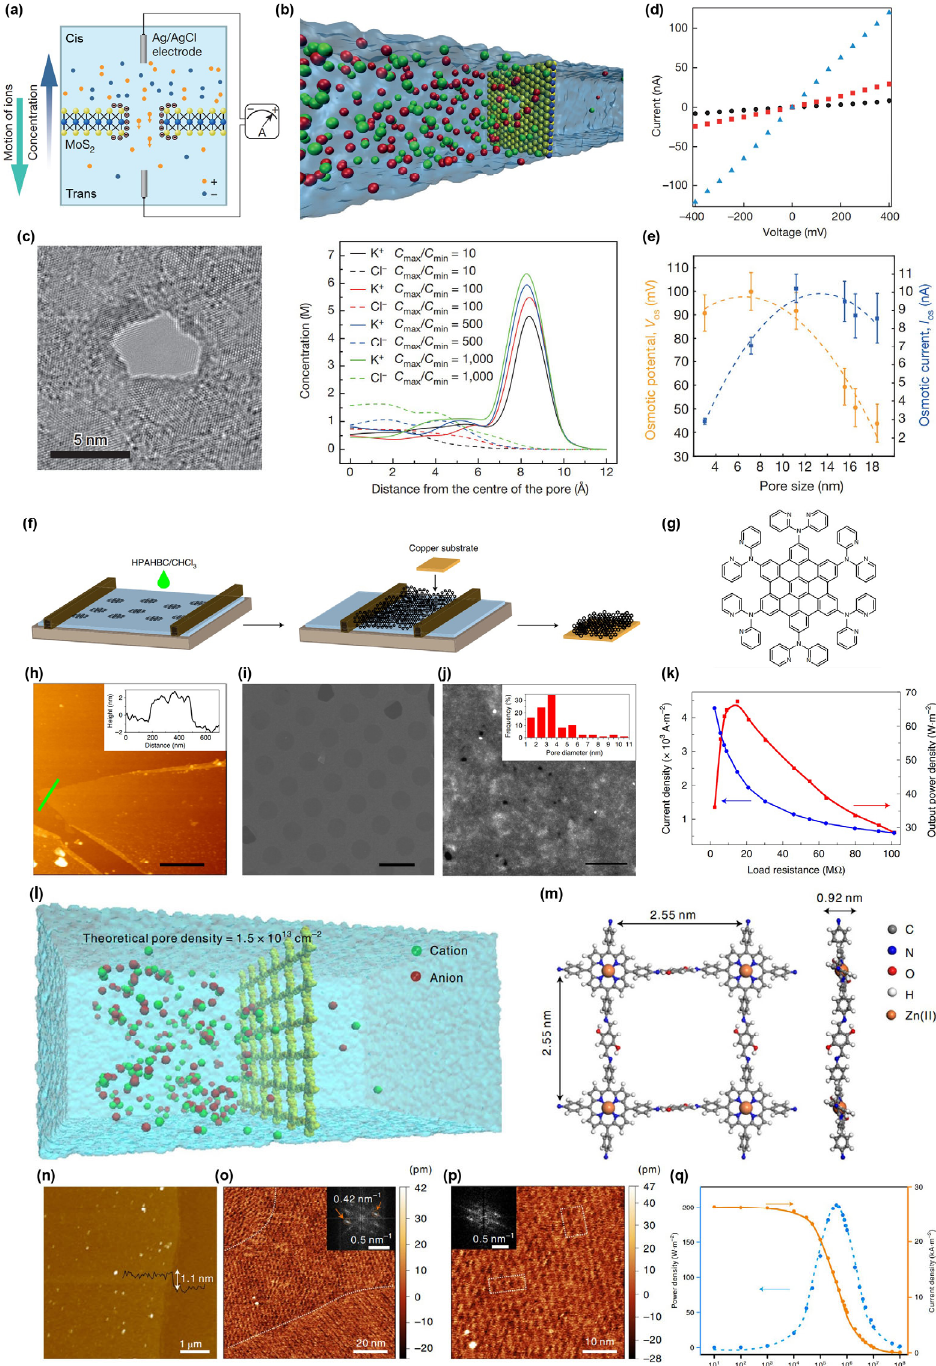
Figure 3 Cation-permselectivity of a 0.65 nm-thick MoS 2 nanopore membrane (a). Top panel, simulation box for MD simulations showing MoS 2 nanopore and the salts. Bottom panel, MD simulation results for potassium and chloride ions of different concentration gradients as a function of radial distance from the pore center (b). TEM-drilled MoS 2 nanopore with a diameter of 5 nm (c). I–V curves of MoS 2 nanopores with different pore sizes (black, 2 nm; red, 6 nm; blue, 25 nm) (d). The osmotic current and osmotic potential as a function of pore sizes (e). Reproduced with permission from Ref. [47], © Macmillan Publishers Limited, part of Springer Nature 2016. Schematic demonstration of the fabrication process for a nanoporous 2D carbon membrane using bottom-up synthesis route (f). Chemical structure of HPAHBC monomer (g). Atomic force microscopy (AFM) image of the membrane (inset, height profile of the membrane). Scale bar, 1 μm (h). Scanning electron microscopy (SEM) image of the membrane on a perforated substrate with an array of 2 μm diameter holes. Scale bar, 4 μm (i). HAADF-STEM image of the membrane showing the nanopores as dark regions on a bright background. (inset, pore size distribution) (j). Current density and power density profiles in 0.5 M/0.01 M NaCl (k). Reproduced with permission